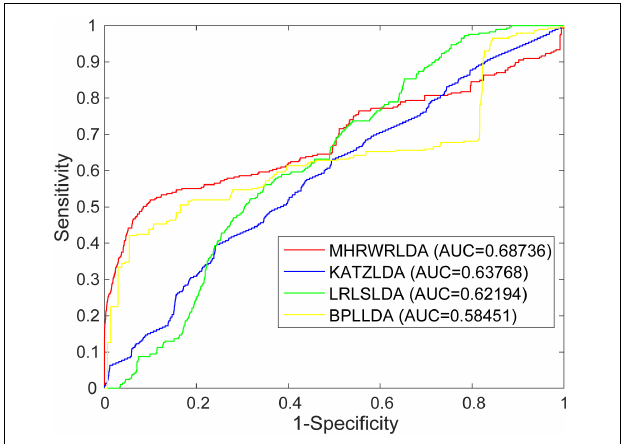
FIGURE 2 | The ROC curves of MHRWRLDA, KATZLDA, BPLLDA, and LRLSLDA based on global